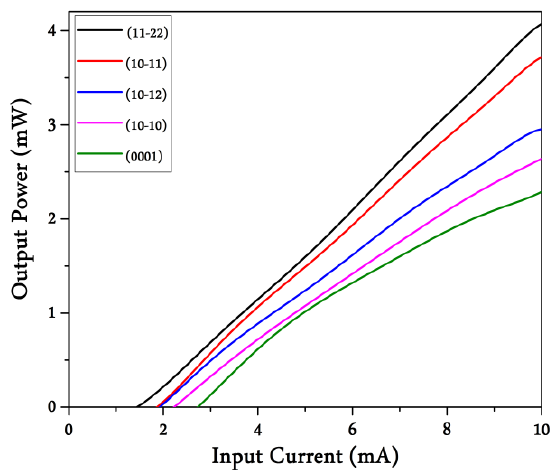
Figure 12. Orientation-dependent output power vs. input current characteristics.